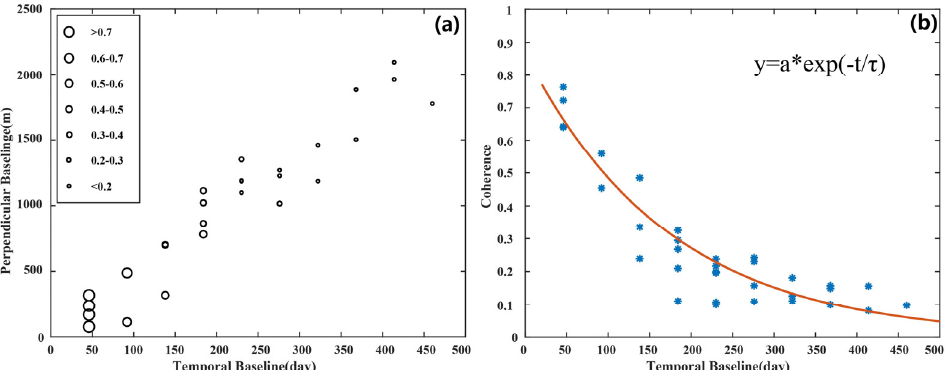
Figure 3. ( a ) Correlation between coherence and perpendicular-temporal baseline variation. Circle sizes stand for different coherence values. ( b ) Coherence variations over temporal baselines. The blue stars indicate the mean coherence values of the study area at different temporal baselines and the orange line represents the fitting curve. a = 0.87, τ = 172 days .